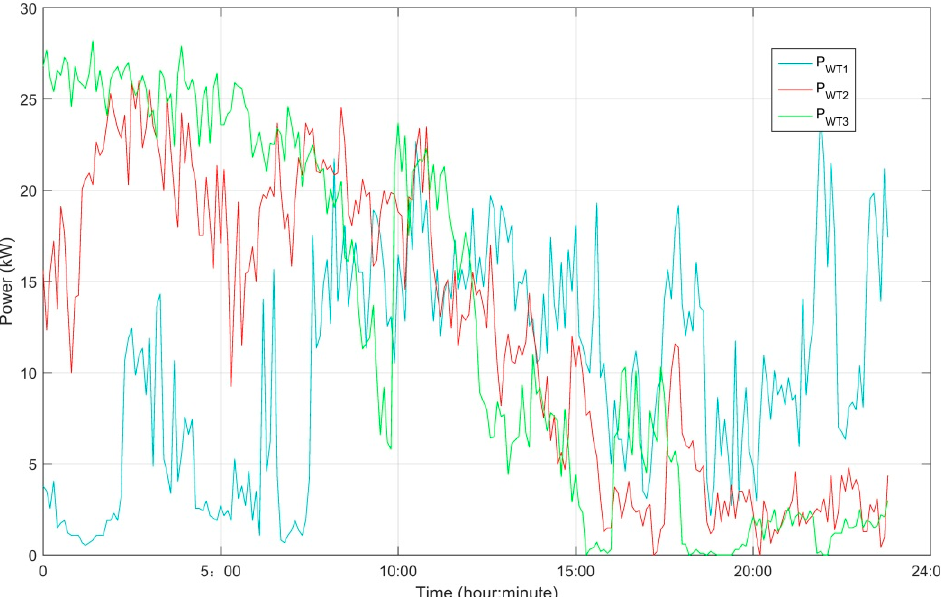
Figure 22. Wind power.